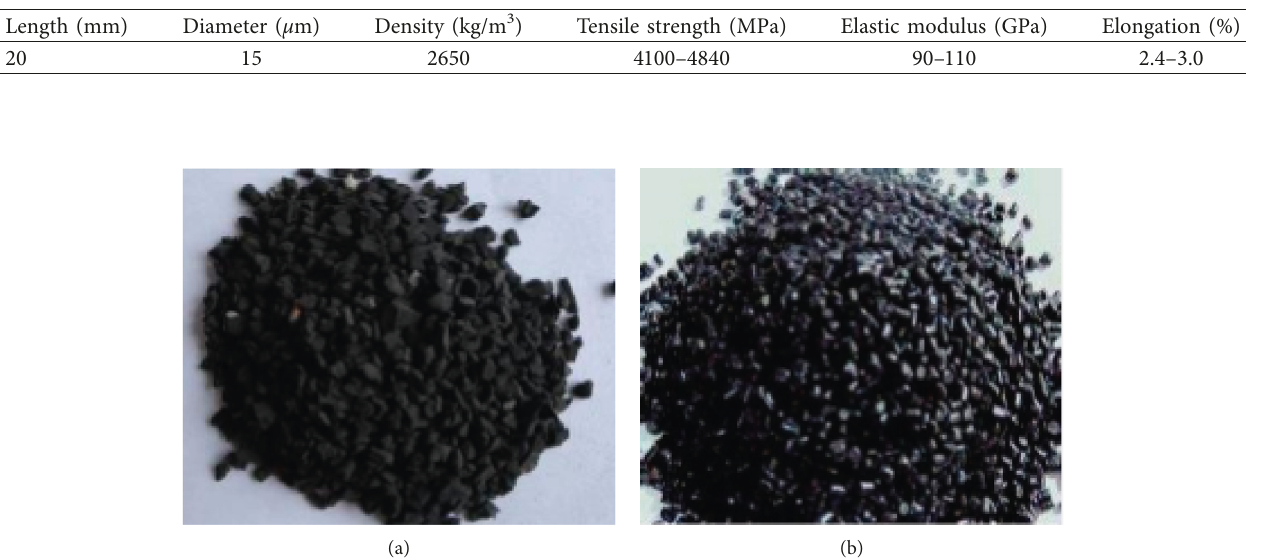
Table 2: Physical and mechanical properties of basalt fiber.